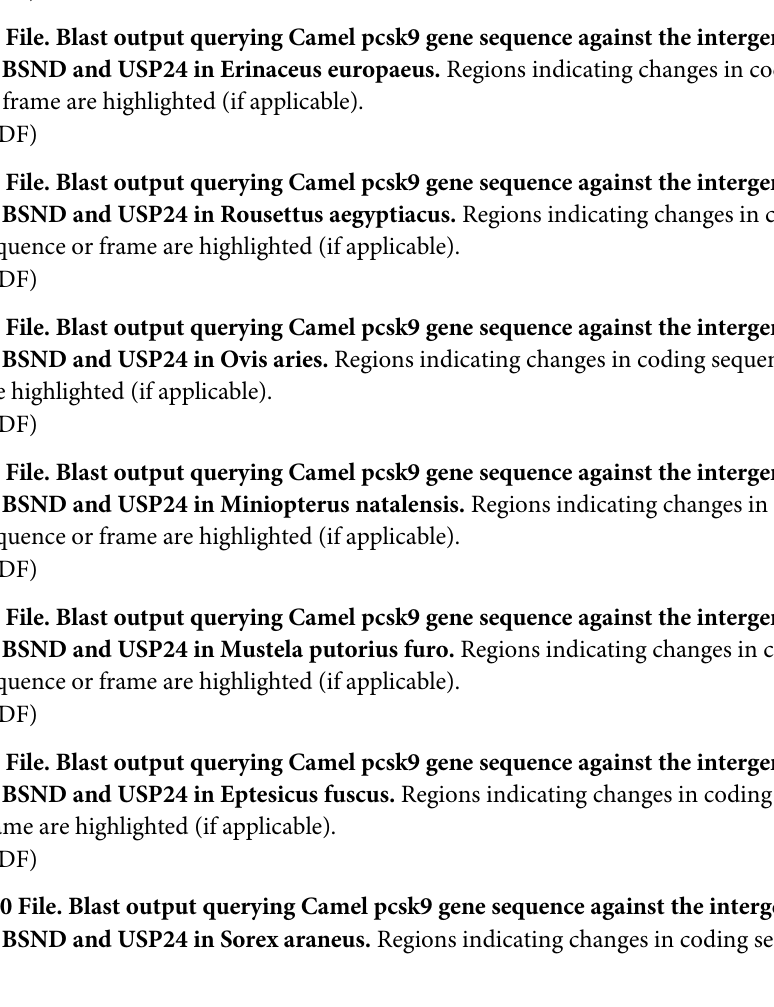
S6 Fig. PCSK9 species tree. The species tree of PCSK9 built by ETE toolkit software for 51 species of 10 major mammalian orders: Three marsupial mammals are considered the out- group. The clades analyzed in PAML software are indicated by different